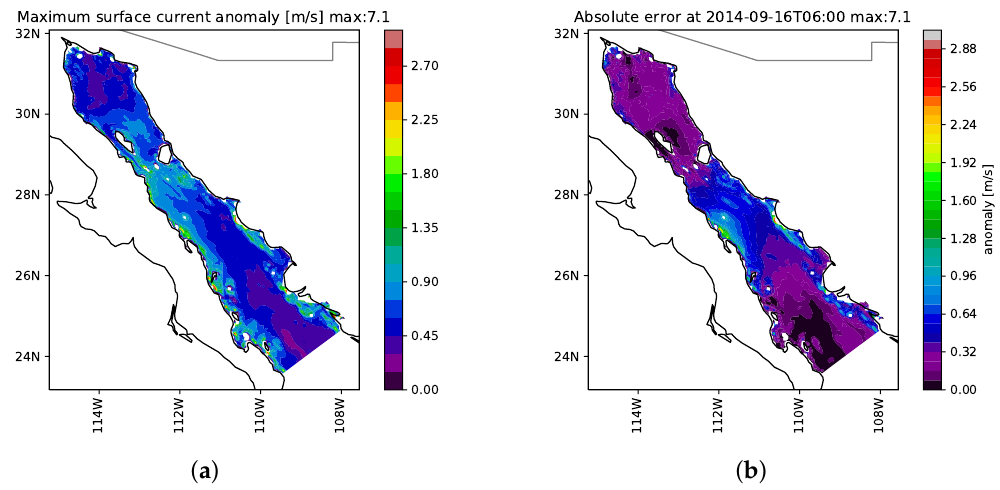
Figure 16. Current anomalies due to Odile. All times in UTC. ( a ) Map of maximum anomaly during simulation period for each grid point. ( b ) Map of the anomaly at the time of the maximum anomaly in the time series (c.f. Figure 14).